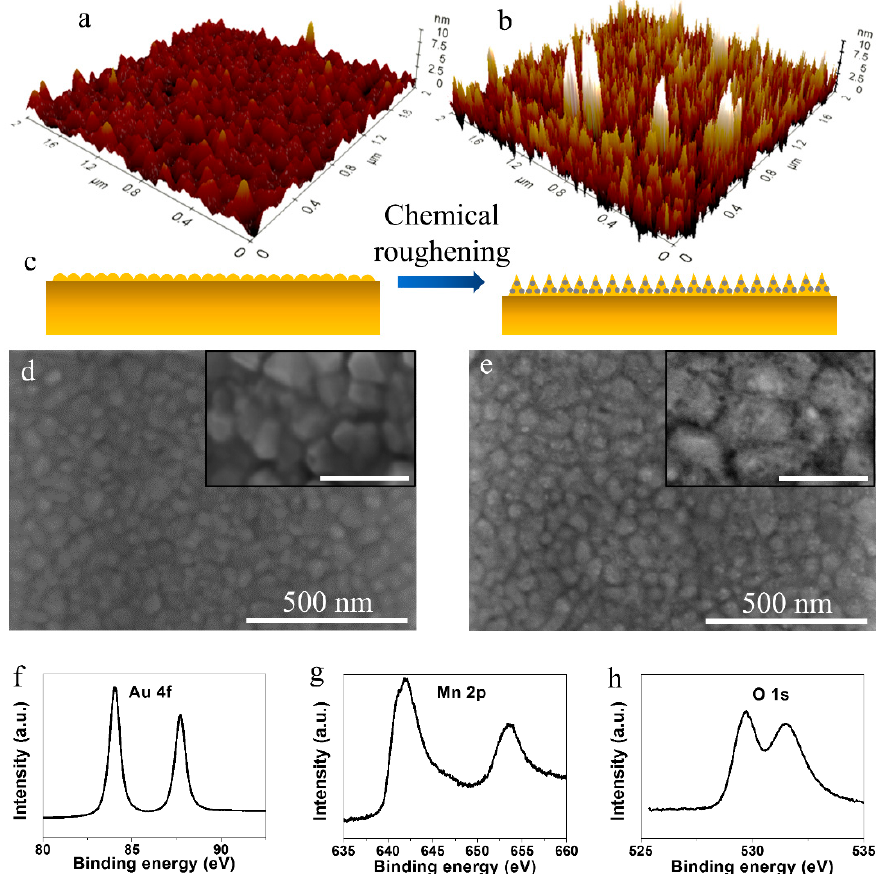
Figure 1. AFM characterization of sputtered Au film on Si/SiO 2 ( a ) before and ( b ) after oxidative etching. ( c ) Sketch of the electrode formation via oxidative etching and in situ trace loading of MnO x . SEM characterization of ( d ) P-Au and ( e ) T-Au/MnO x (inset scale bar is 100 nm). XPS characterization of T-Au/MnO x electrode for ( f ) Au 4f orbit, ( g ) Mn 2p orbit, and ( h ) O 1s orbit. From the CV comparison result in the three-electrode test (Figure 2a), it was found that the T-Au electrode with loaded trace MnO x displayed typical capacitive behavior and much larger integrated capacitive current than P-Au; this was attributed to the increased number of electrochemical active sites for electrical double layer capacitance via surface roughening and the grown pseudo-capacitive MnO x on the Au nano-islands. An areal ca- pacitance of 380 µF cm − 2 was achieved at 100 mV s − 1 (capacitance calculation, presented in Supplementary Materials). Figure 2b indicates that an ideal, rectangular shape of CV curves could be maintained in a wide range of CV sweeping rates in the three-electrode test. With the T-Au/MnO x on Si/SiO 2 substrates as the electrodes, the electrochemical per- formance of the on-chip full cell was studied. Generally, the phase angle at 120 Hz is sig- nificant for 60 Hz AC response. The assembled on-chip full cell showed a phase angle of − 78° at 120 Hz (Figure 2c), which was very close to that of commercial AECs for AC filter- ing (typically, with a phase angle of around − 80° at 120 Hz [12]), indicating its high fre- quency response capability. The resistor-capacitor (RC) time constant ( τ RC ) was calculated to be 0.27 ms, i.e., much smaller than 8.3 ms (for 120 Hz filtering). This τ RC also confirmed its promising high frequency handling capability. The measured Nyquist plots (Figure 2d) revealed a low equivalent series resistance (ESR) of the on-chip HFSC (0.38 Ω cm 2 ). To the best of our knowledge, this is the lowest ESR of any supercapacitor based on nonconduc- tive pseudocapacitive active materials to date. The low ESR is beneficial for the fast re- sponse; we attributed this to two aspects: (1) a very good chemical bonding between MnO x and Au, realized by the redox reaction (between Au and KMnO 4 ) -promoted deposition,